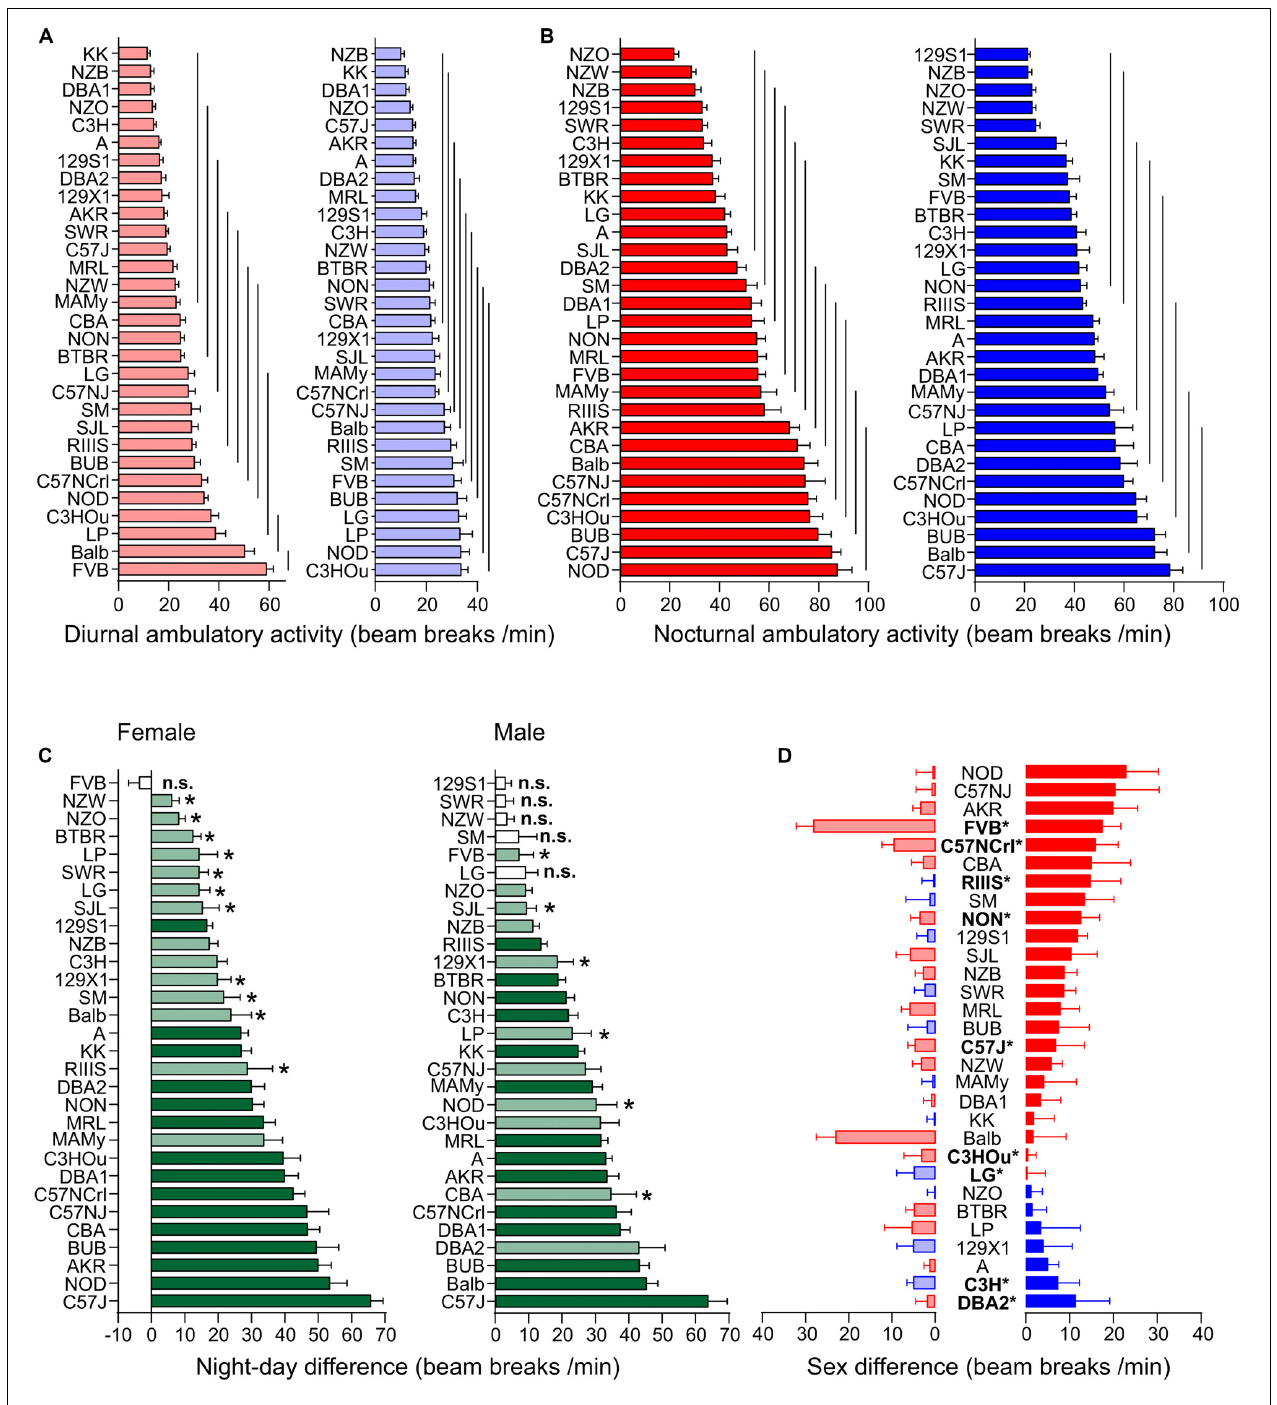
FIGURE 4 | Strain, day–night and sex differences in ambulatory activity. (A,B) Strain-dependence of diurnal (A) and nocturnal (B) ambulatory motor activity. The values are given as mean values averaged from females (left, red) and males (right, blue) with standard errors of the mean. The vertical lines connect groups with homogenous means according to Tukey’s post hoc test. (C) Day–night differences were ranked and Cohen’s D calculated. Differences were indicated with one asterisks at p < 0.05; p -levels < 0.001 were not marked; “n.s.” not significant. The effect sizes ranged from D = 0.48 (FVB males) to D = 5.09 (C57J females) and are indicated in light green ( D = 0.48 and D < 2) and dark green ( D ≥ 2). (D) Sex differences were apparent in nine strains at p < 0.05. The strains are ranked from largest to smallest sex difference for the scotophase, beginning, at the top, with strains, where females (red) were more active than males, while blue columns illustrate strains with more active males. To the left, nocturnal values are associated with the respective diurnal values and are displayed in light colors. All values are displayed as means ± standard error of the difference. Asterisks and bold font indicate sinificant sex differences, * p < 0.05.